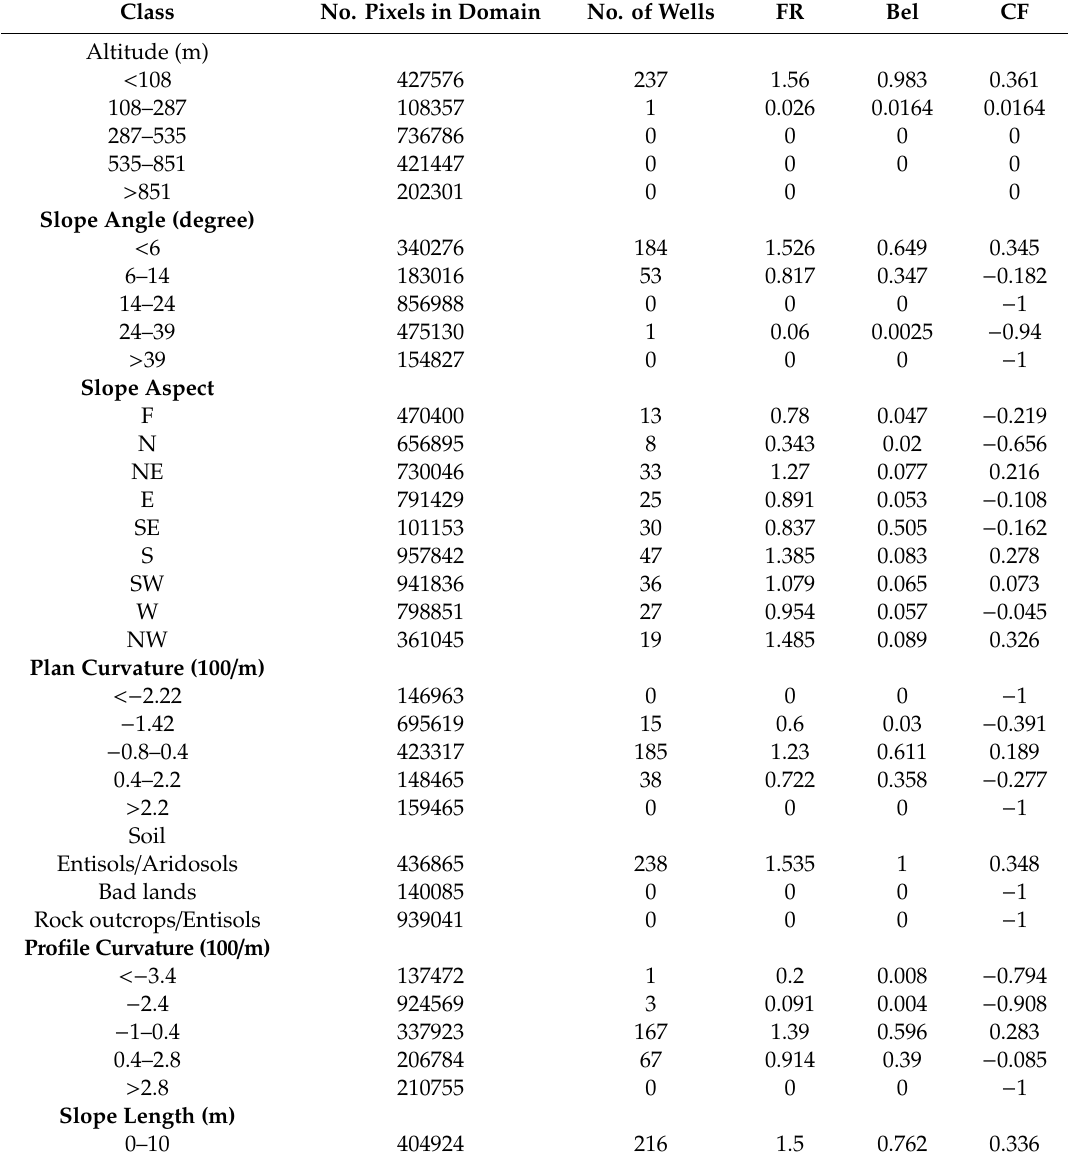
Table A1. Result of three bivariate statistic